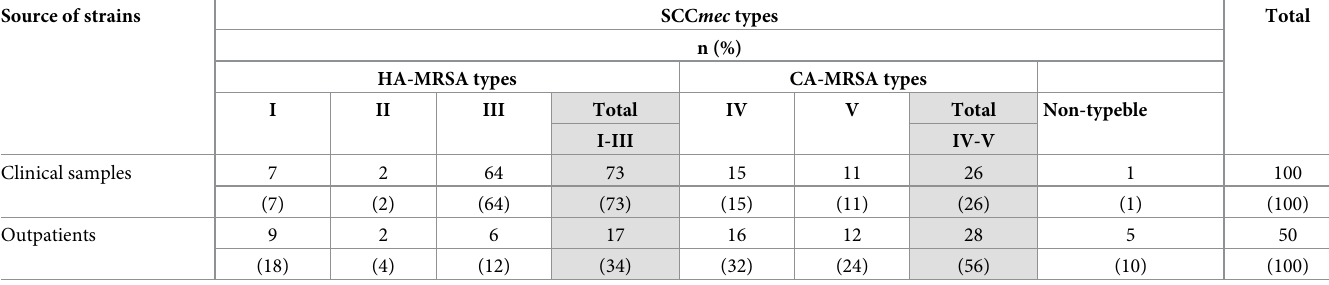
sequence type. Regardless of some differences in PFGE macrorestriction profiles of six MRSA strains, all of them belonged to the same sequence type, ST152, already known as a toxin pro- ducer. Spa type t 1096 was found in one strain of outpatient origin (Table 2). All other tested strains, one from outpatient and four from clinical samples, were of spa type t 355. Table 1. SCC mec types of MRSA isolates from clinical and outpatients´ samples. Source of strains